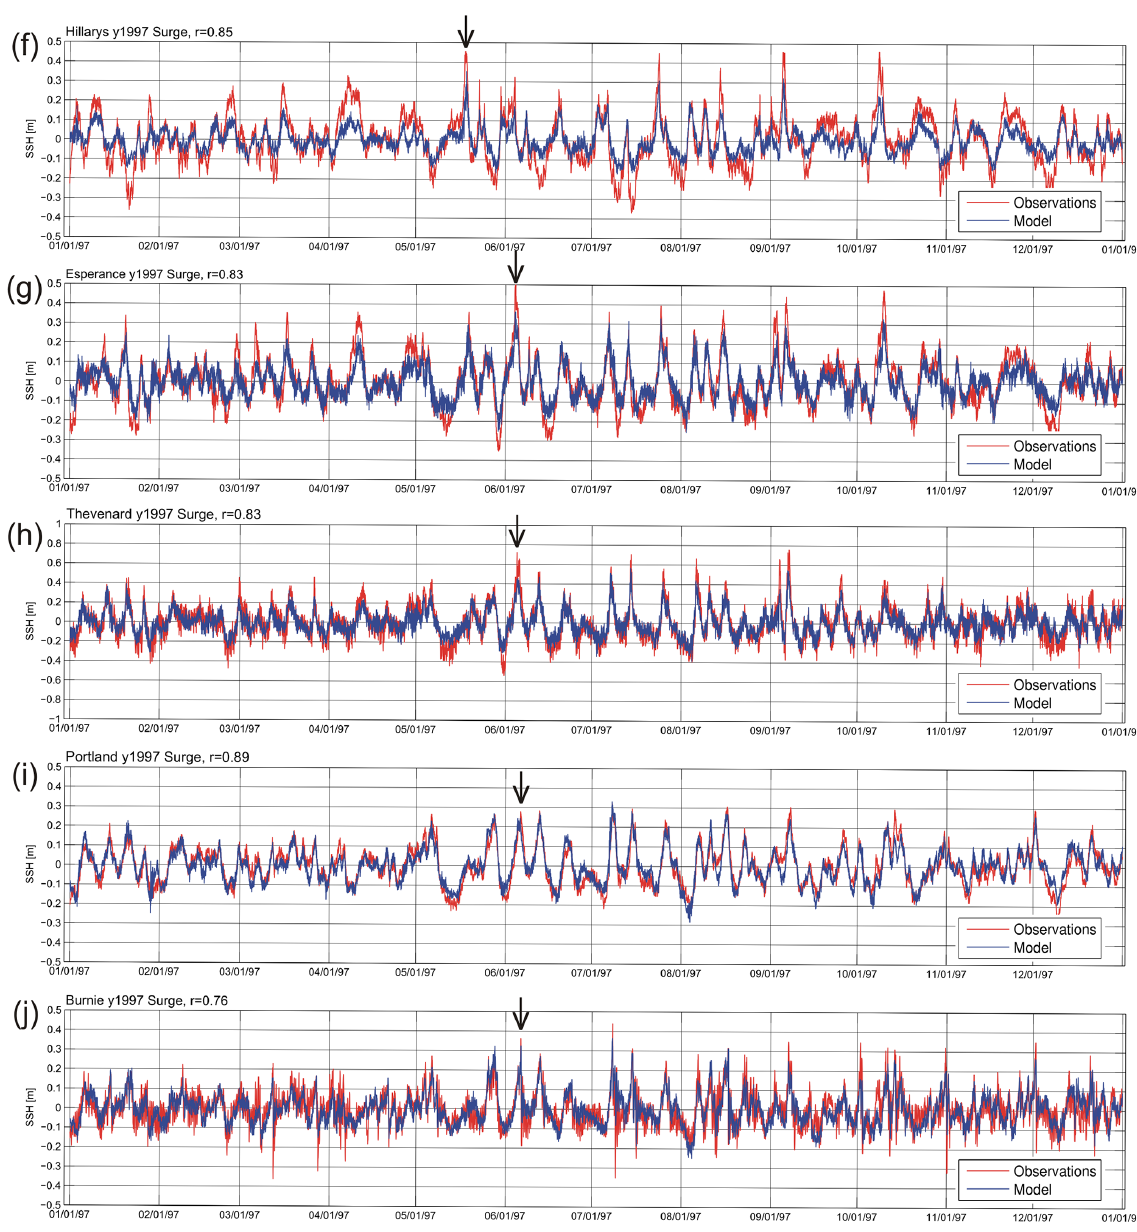
Figure 3. Comparison of sea level residuals from tide gauge observations (red) and baseline model experiment (B-TM) for 1997. Black arrows indicate storm surge events discussed in the text. SSH: sea surface